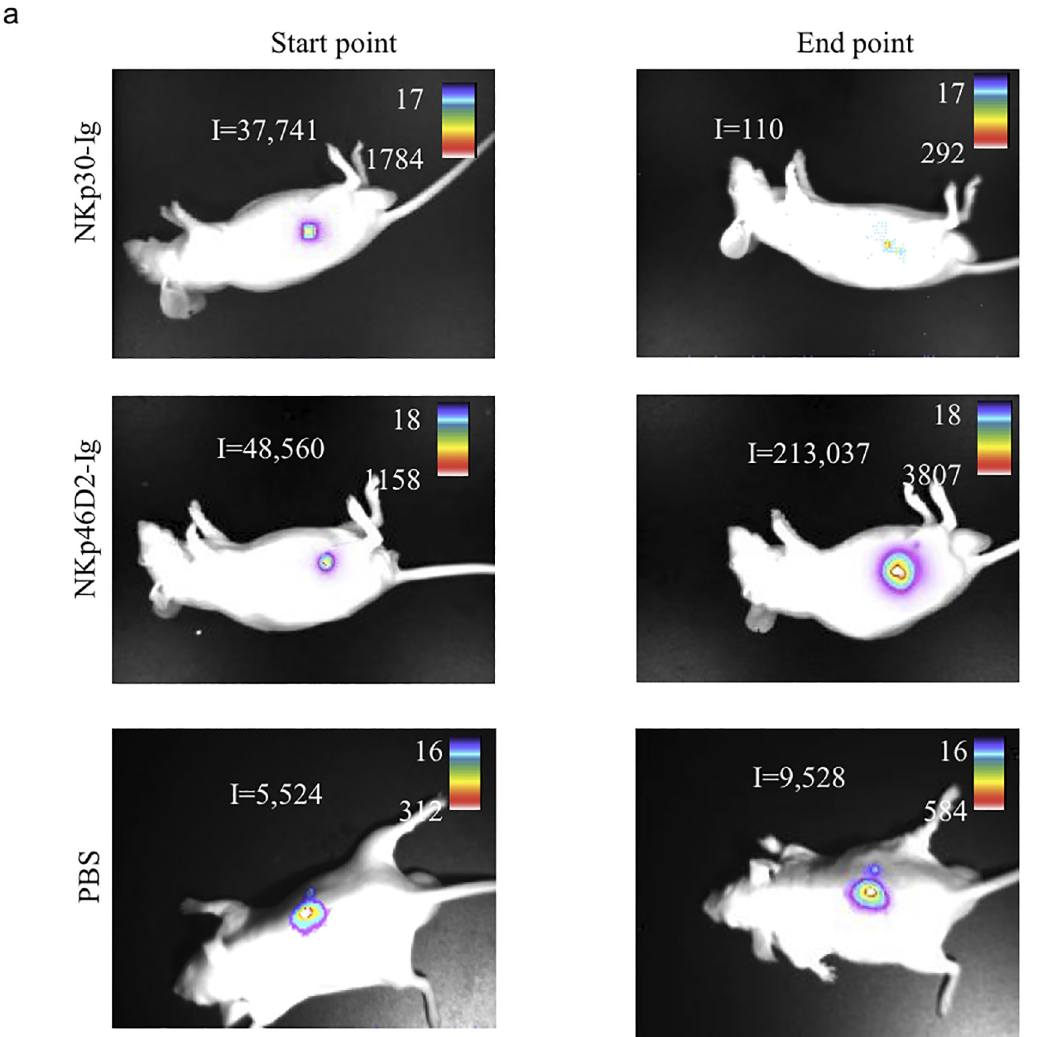
Fig 4. Summary of fusion protein treatment. (a) Visualization of tumor progression and distribution in vivo. The figure shows an image visualization of one representative animal of each treatment. The scale on the right of each figure describes the color map of the photon count. The integrated light emission ( ‘ I ’ ) is indicated in the left of each photo. (b) Summary of treatment effect. Table describes the overall effect of treatments, as shown in details in Fig